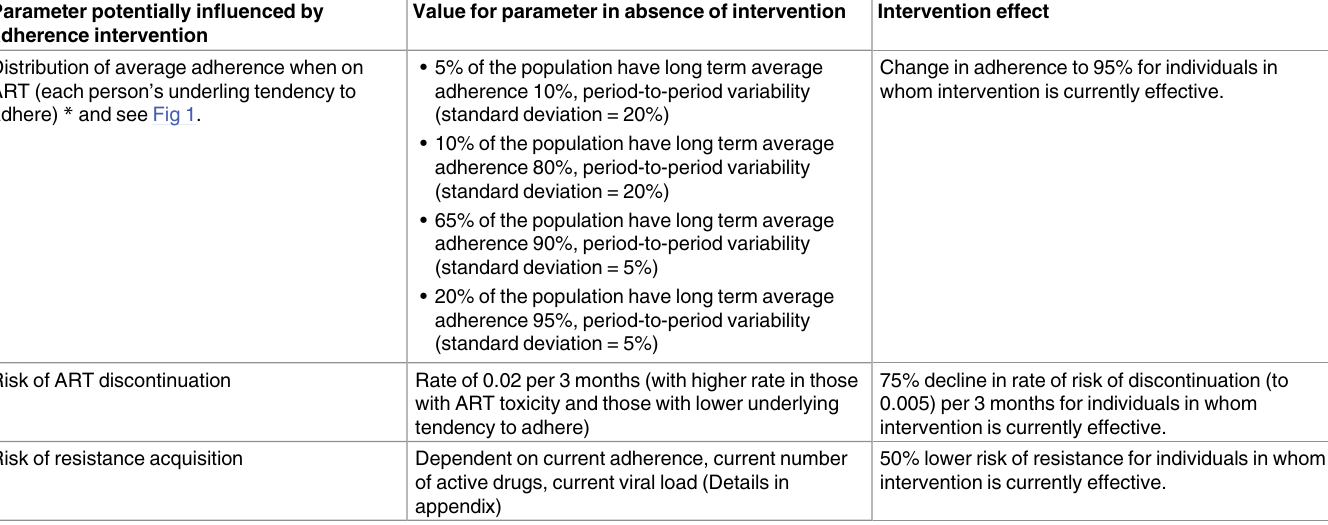
Table 1. Modelled intervention effectsin individuals in whom adherence monitoring intervention is currently effective. In each case, this represents a large effect at the individuallevel—the overall effect of the intervention is then determined by the percent of peoplein whom the interventionis effective. Parameter potentially influenced by Value for parameter in absence of intervention Intervention effect adherence intervention Distribution of average adherence when on ART (each person’s underling tendency to adhere) * and see Fig